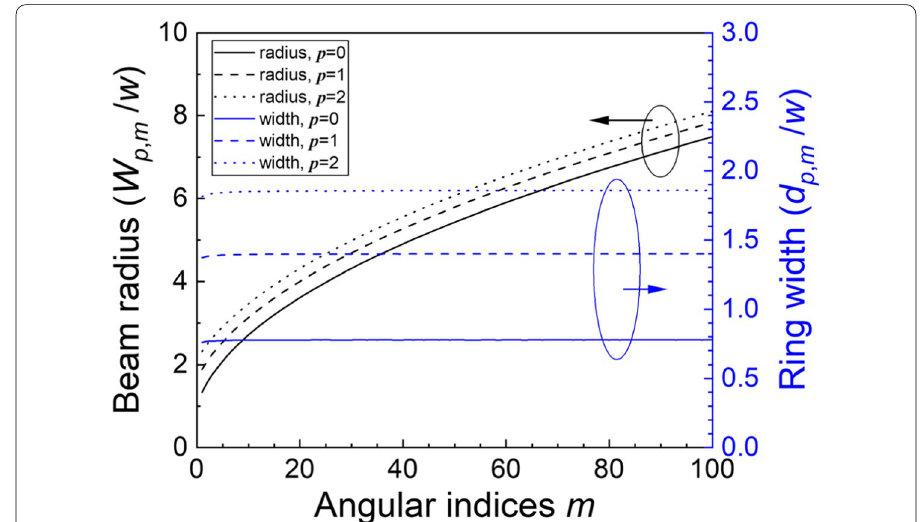
Fig. 2 The beam radius W p,m and ring width d p,m of LG modes normalized to the lowest order “fundamental” mode radius w, as a function of angular indices m , with radial indices p of 0, 1 and